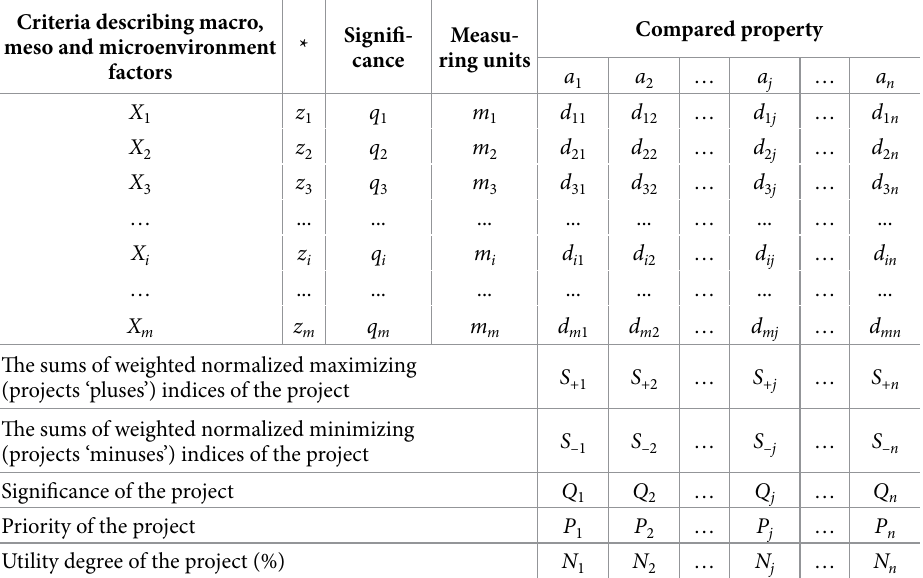
table 1. Environment factors multiple criteria analysis results Quantitative information pertinent to projects criteria describing macro, meso and